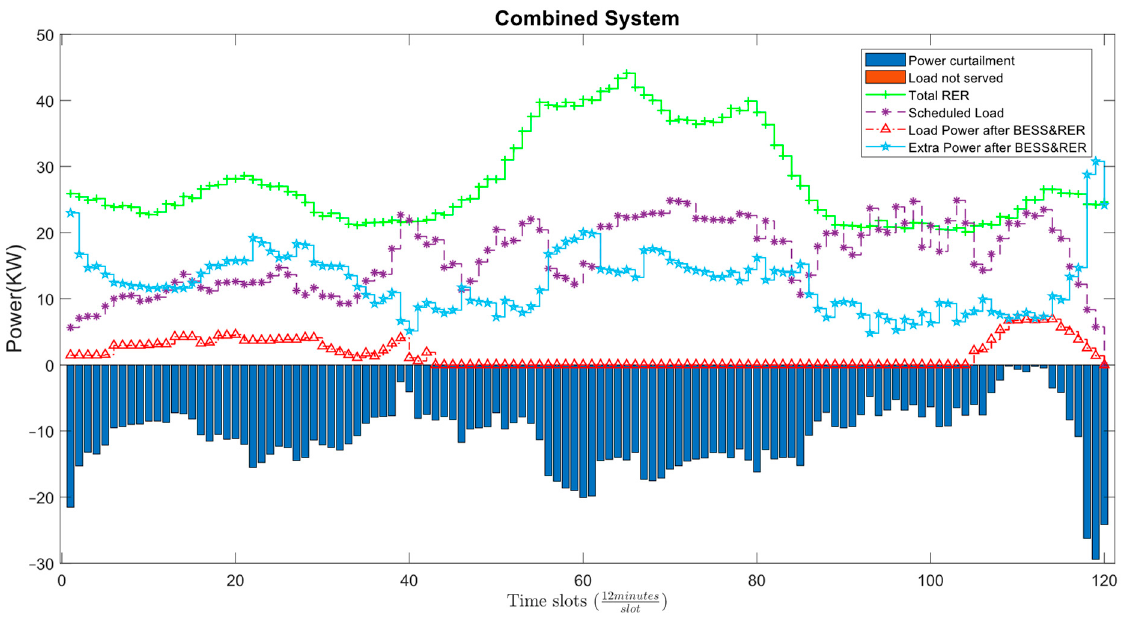
Figure 29. Energy management system for scheduled load using scenario 3.